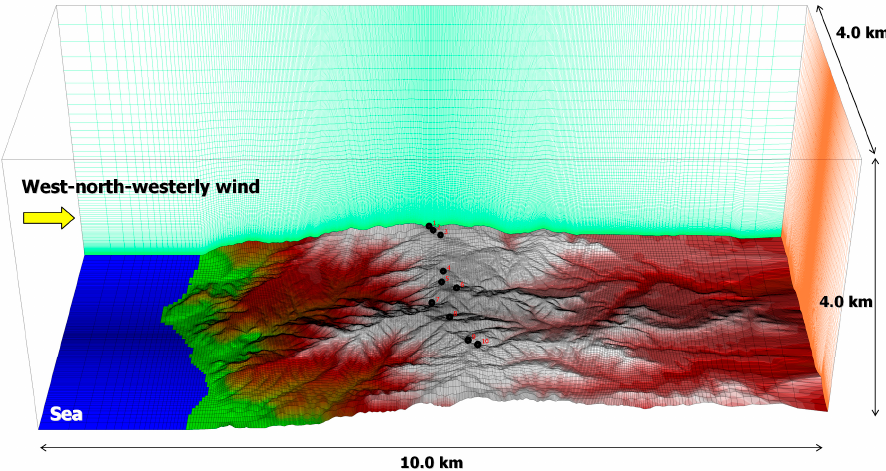
Figure 10. Computational domain and grid used for the present study.